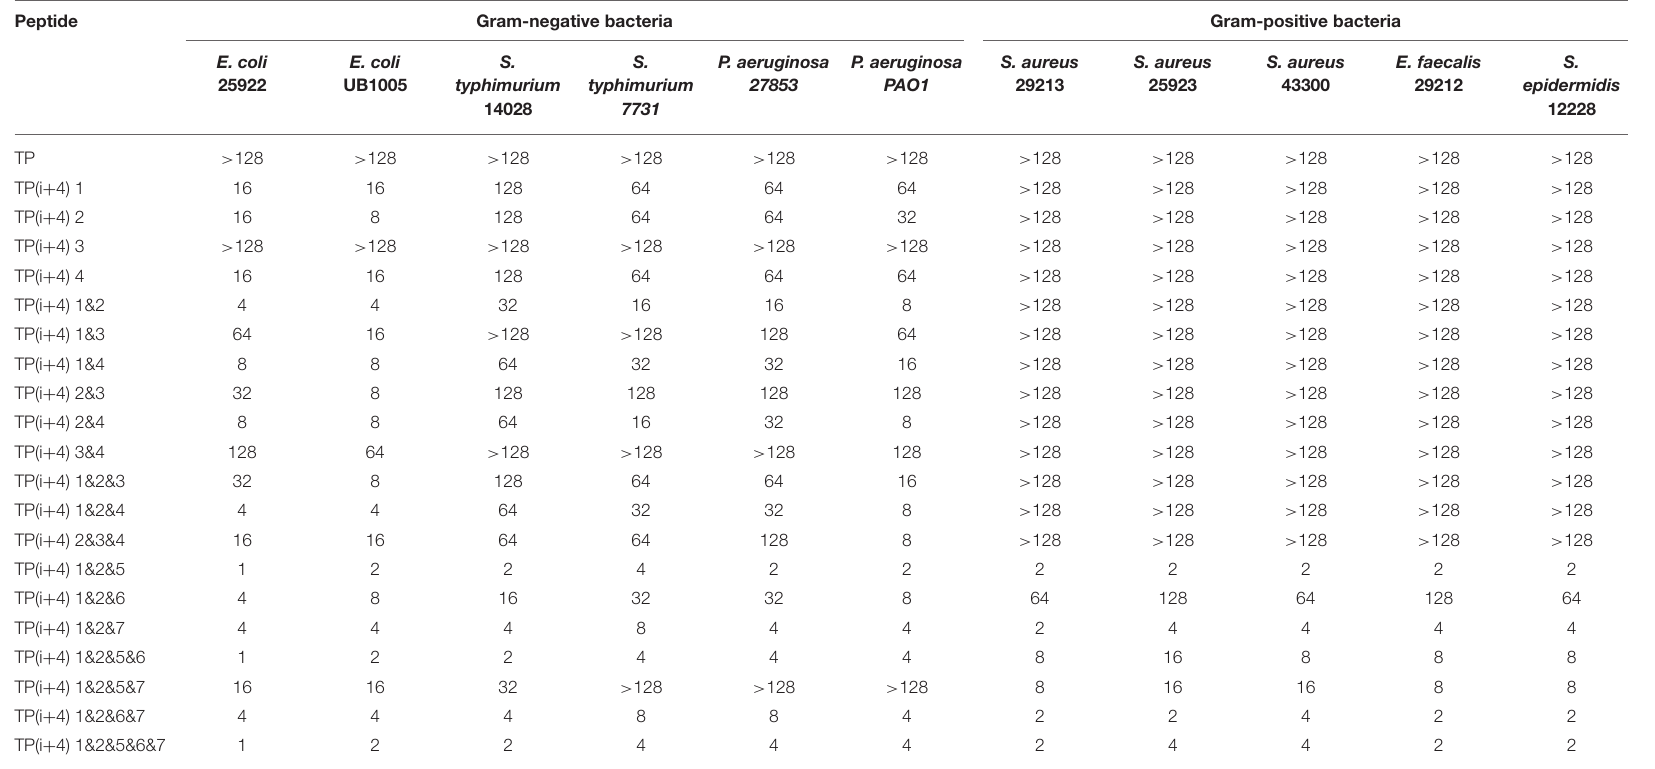
TABLE 2 | The MICs a ( µ m) of the peptides.